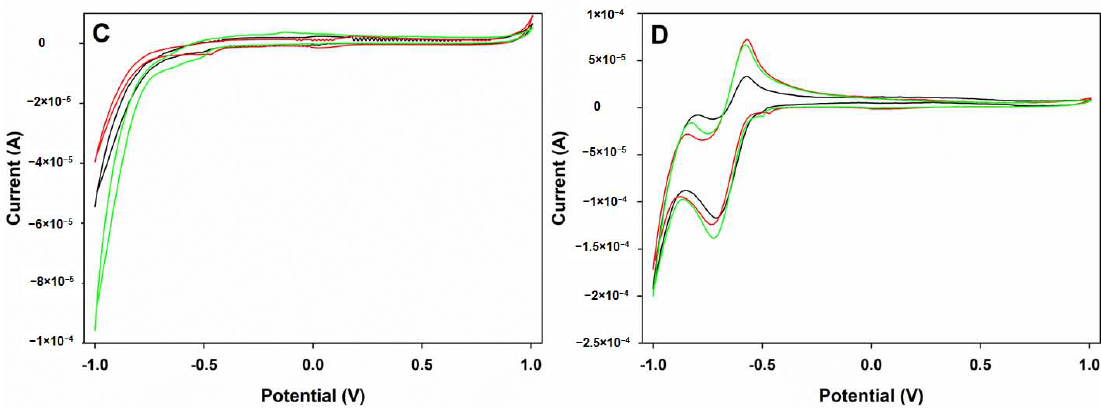
Figure 5. Cyclic voltammograms of picric acid (green), 2,4-dinitrophenol (black), and 4-nitrophenol (red), 50 µ g · mL − 1 individual solutions with ( A ) Ag electrode; ( B ) epoxy graphite electrode; ( C ) gold electrode; and ( D ) platinum